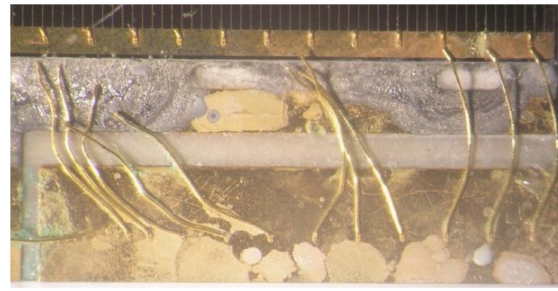
Figure 12. Examples of copper oxides.